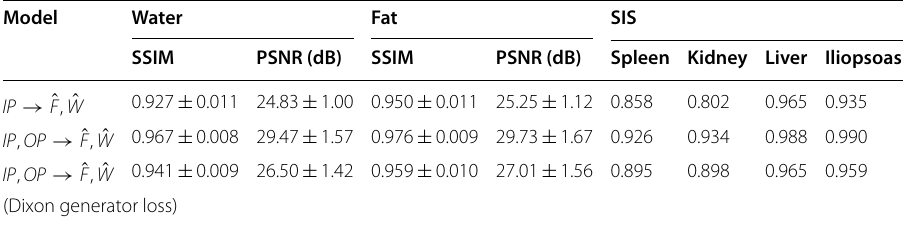
In addition to PSNR and SSIM, we computed the semantic interpretability scores (SIS) for the spleen, kidney, liver and iliopsoas muscle segmentations